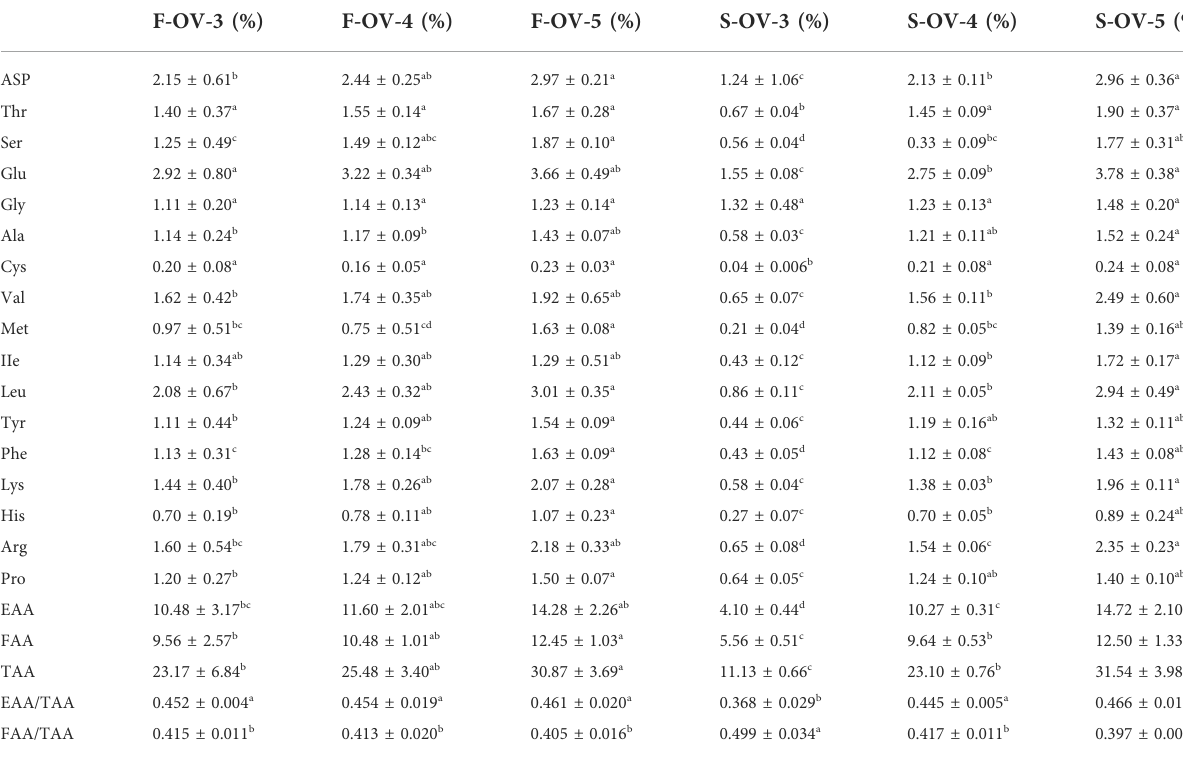
TABLE 5 Pro fi le of amino acids in female Scylla paramamosain ovary during the two vitellogenesis